Question: Name the type of graph shown.
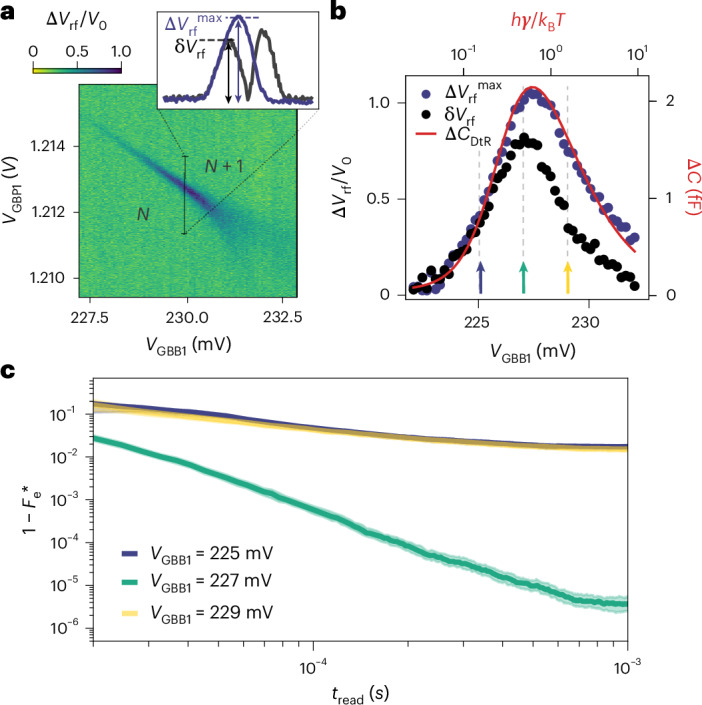
Answer: line